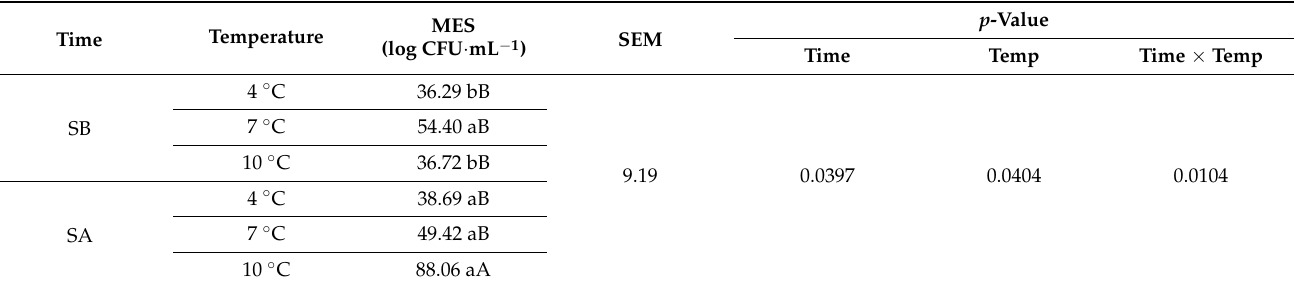
Table 1. Effects of immersion of rabbit carcasses in the pre-chiller, water temperature, and their interaction on the count of mesophilic aerobic heterotrophic microorganisms (MES).